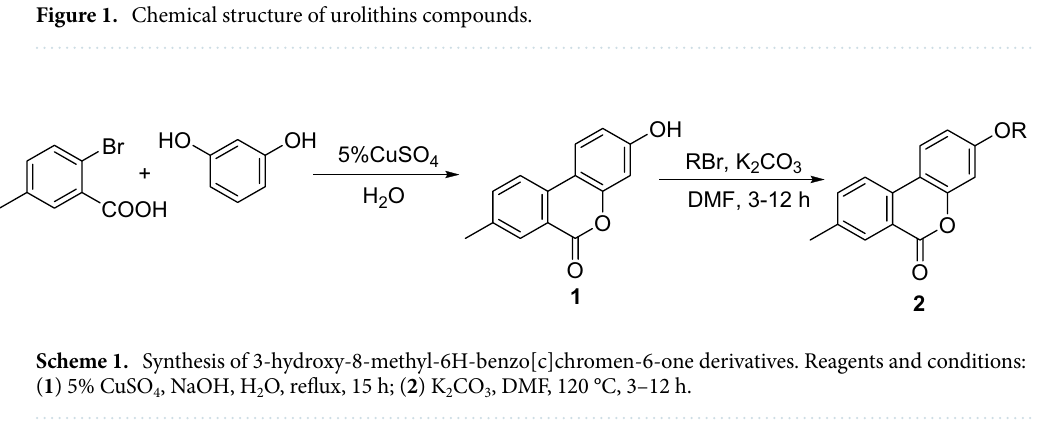
Figure 1. Chemical structure of urolithins